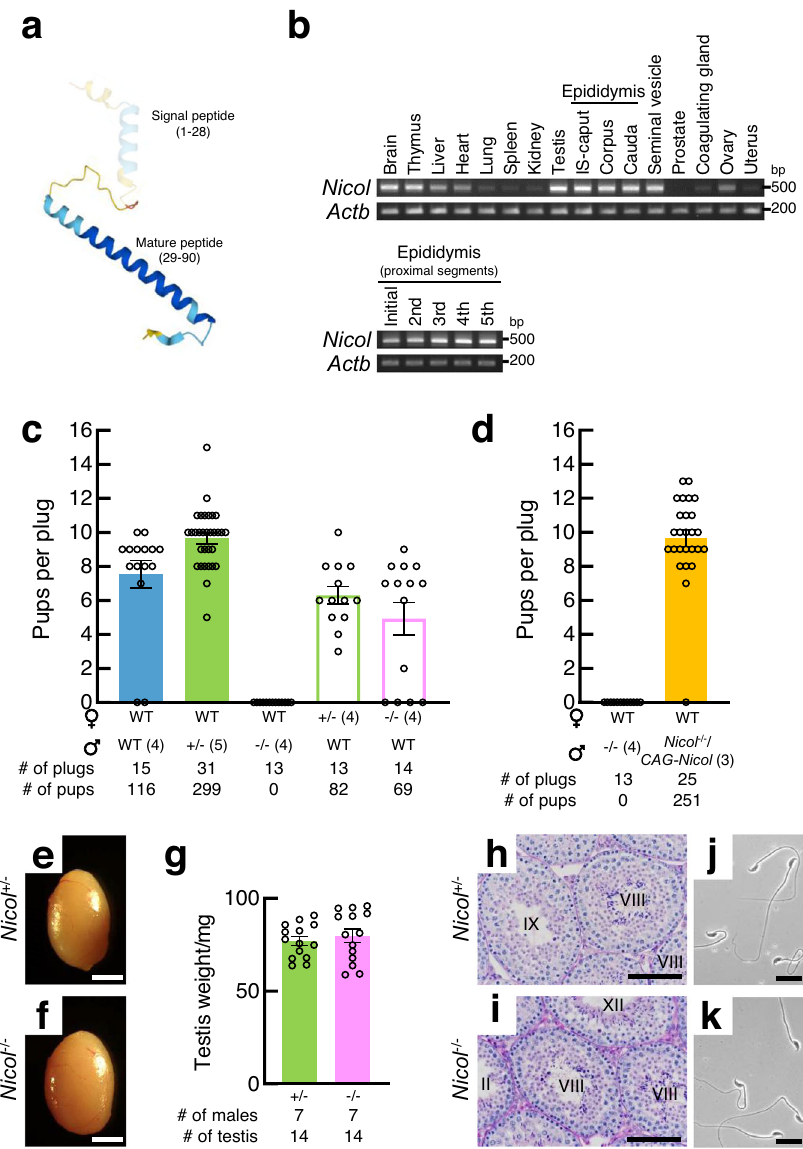
− / − / CAG-Nicol males. Average and S.E. shown. e – k Appearance of testis ( e , f ), testi- cular weight ( g ), HE staining of testis sections (h,i), and epididymal sperm morphologies ( j , k ) in Nicol +/ − ( e , h , j ) and Nicol − / − ( f , i , k ) mice. Stages of sperma- togenesis indicated by Roman numerals ( h , i ). Images are representative ones obtained from three independent biological replicates ( e , f , h – k ). For bar plots, values are shown as mean±S.E.M. P value=0.5538 was determined by a two-tailed unpaired Students ’ t -test ( g ). Scale bars, 2mm ( e , f ), 100 µ m ( h , i ), 20 µ m ( j , k